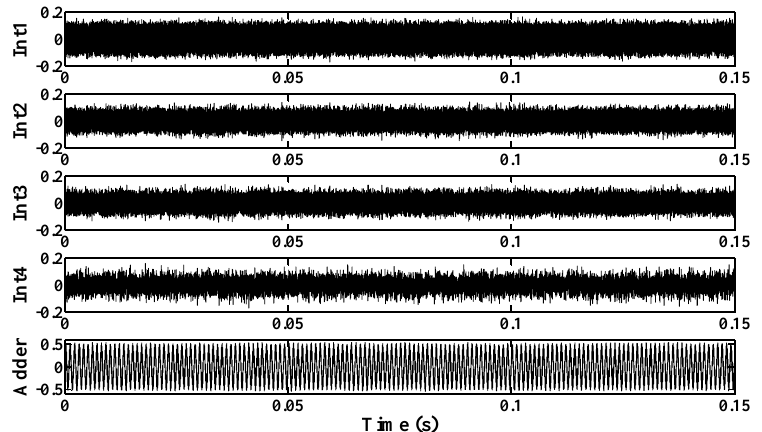
Figure 9. Simulated output swings of several circuit blocks in the proposed